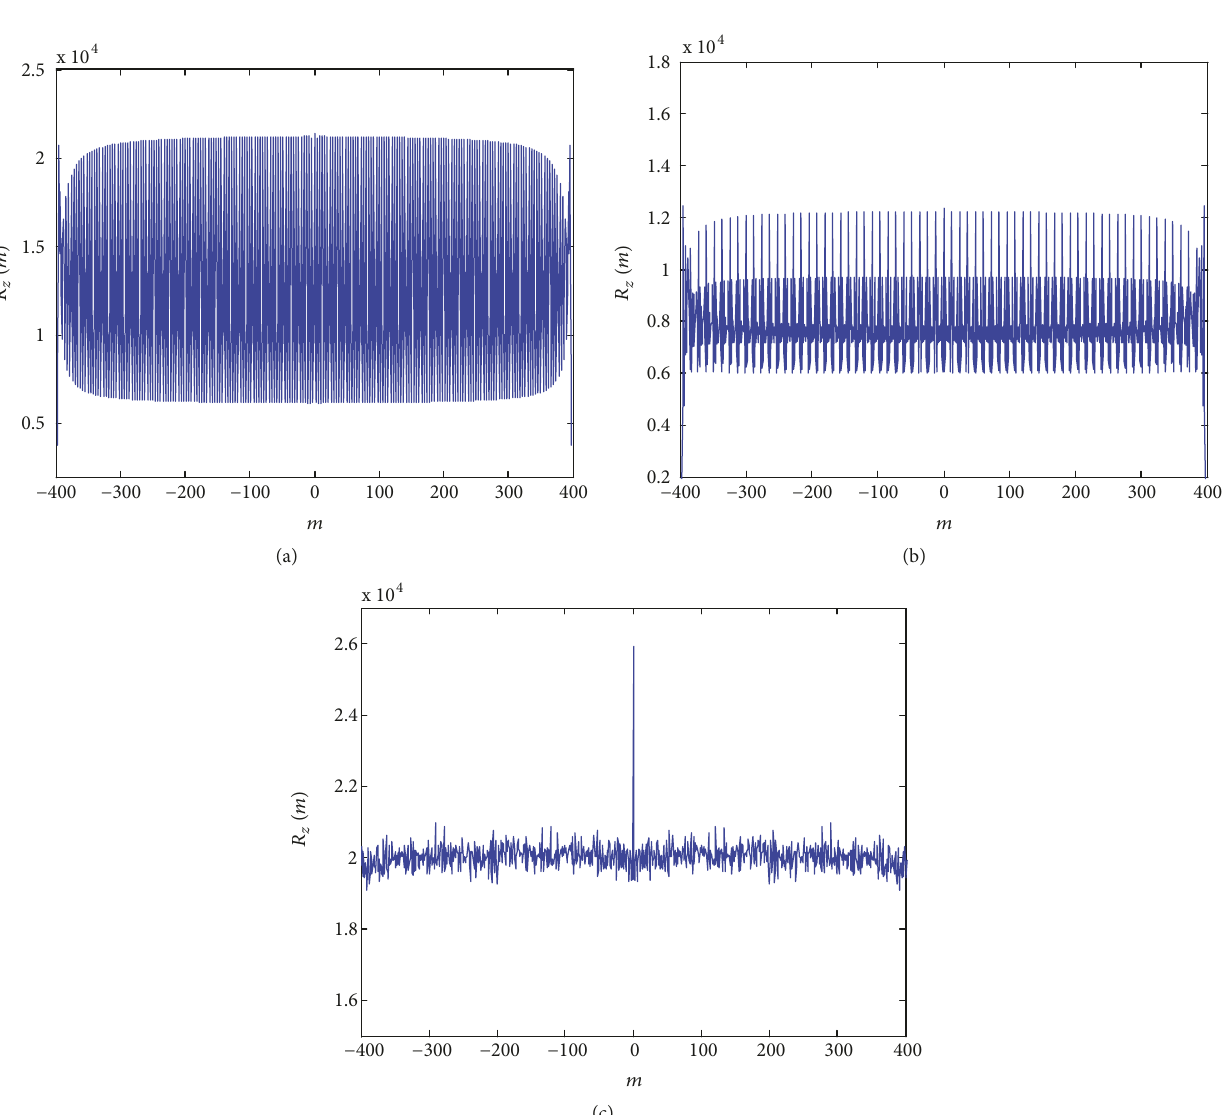
value of each round of Logistic and Tent mapping constitutes a new discrete chaotic